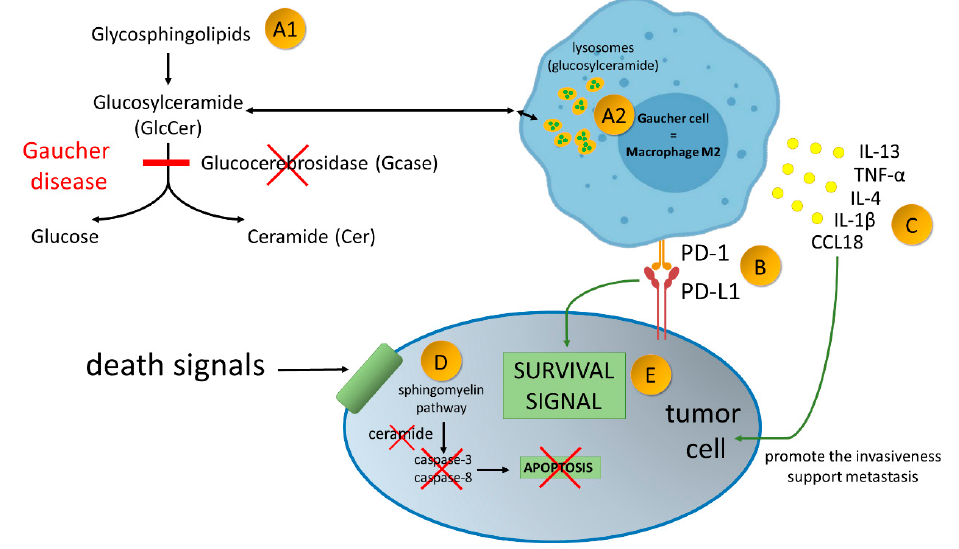
Figure 2. Gaucher disease—an inherited metabolic disorder caused by mutations in the gene GBA1 , encoding acid- β -glucosidase (GlcCerase; Gcase)–A1. It leads to accumulation glucocerebroside in macrophages–A2. Gaucher Cells resemble alternatively activated macrophages (M2). Alternatively activated macrophages/Gaucher cells, play a pro-tumoral role in tumor microenvironment. PD-1